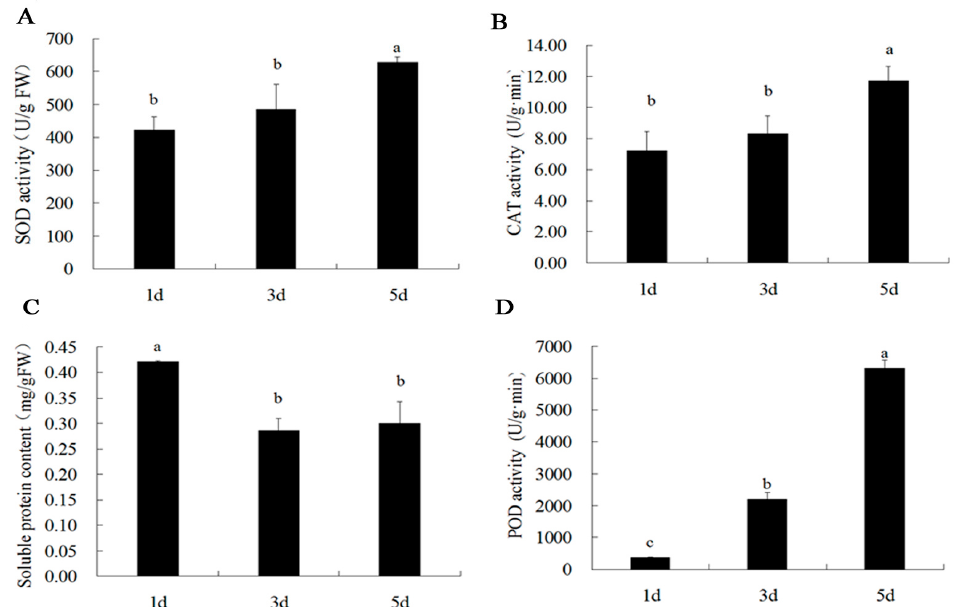
Figure 7. Activity of antioxidant-related enzymes, superoxide dismutase (SOD) ( A ), catalase (CAT) ( B ), soluble protein content ( C ), peroxidase (POD) ( D ), and in B. acuminata petals during blooming. Values (mean ± SD) were determined from three independent experiments ( n = 3). Different letters above the bars indicate a significant difference at p < 0.05.